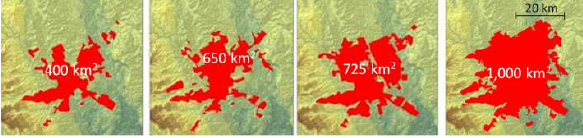
Figure 1. Size of Ar Rijadh in 1980, 1990, 2000 and 2010